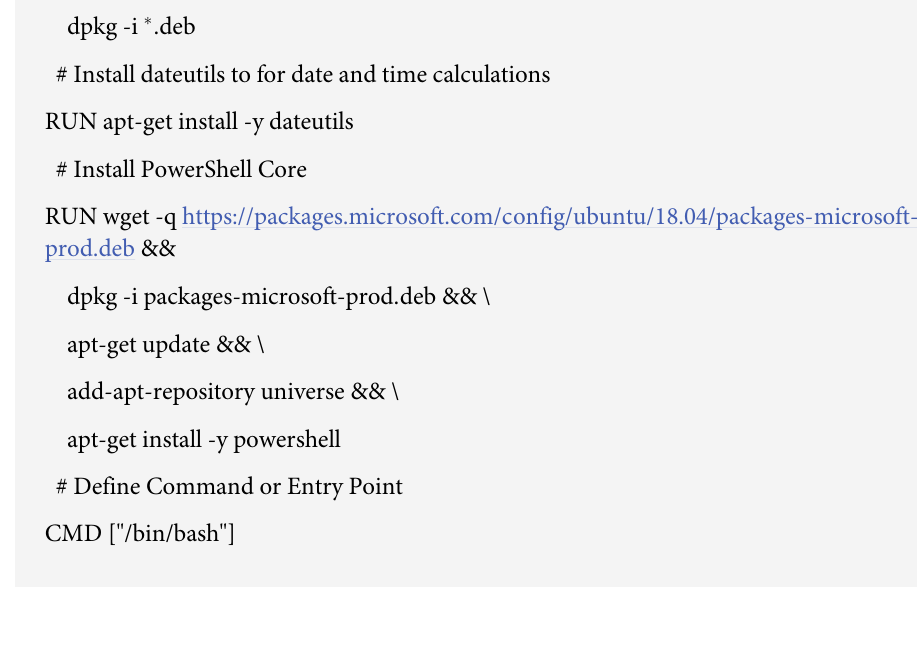
(Highlighted value: the value for this variable can be modified to build the container with